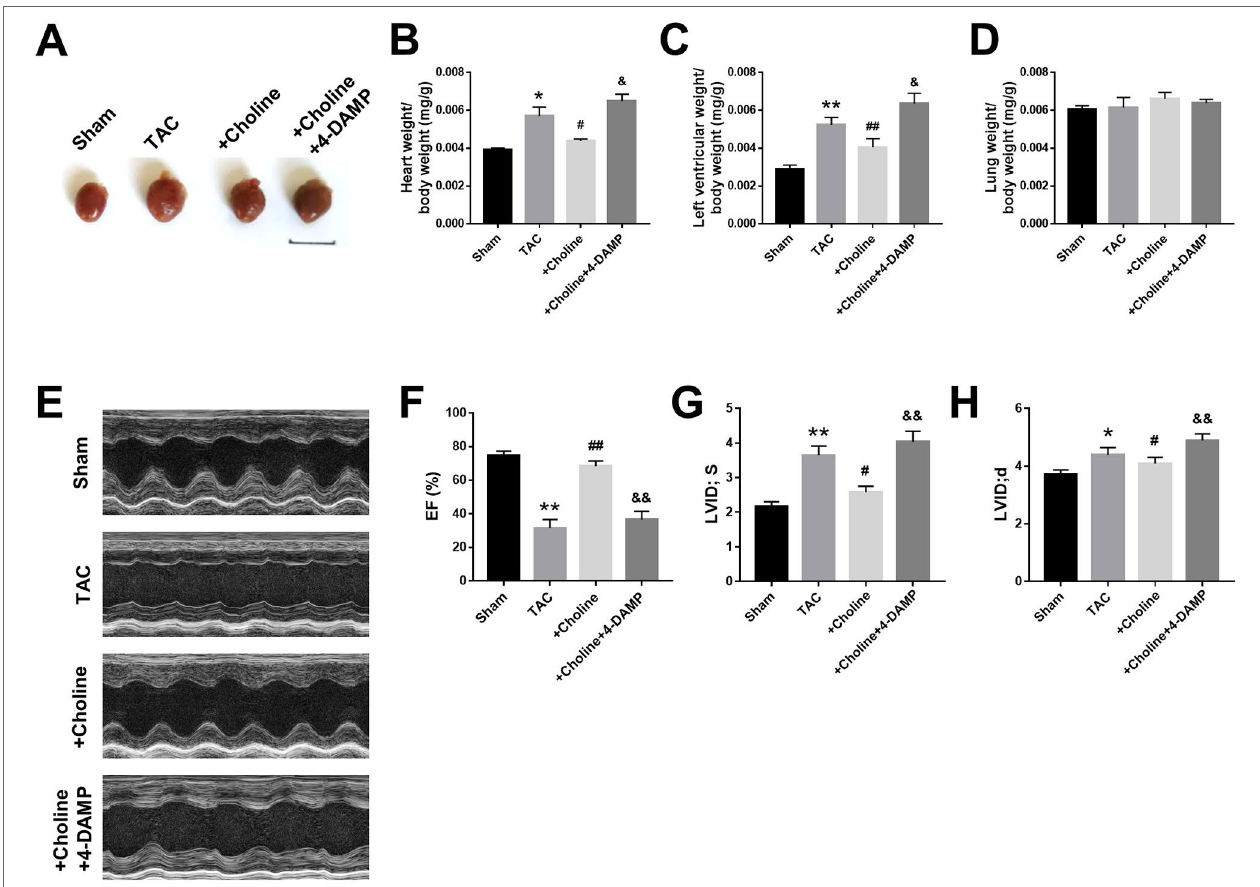
FIgURe 3 | Effects of choline on cardiac function of transverse aortic constriction (TAC) mice model. (A) Representative hearts from sham, TAC, and the mice induced by TAC treated with choline (14 mg/kg per day) and 4-DAMP (0.7 μg/kg/day) for 8 weeks. (B) The ratio of heart weight/body weight (BW). (C) The ratio of left ventricular weight (LVW)/BW. (D) The ratio of lung weight/body weight. (e) Representative echocardiographic images of mouse hearts in each group. (F) Left ventricular ejection fraction (LVEF). (g) Systolic left ventricular internal diameter (LVID, s). (h) Diastolic left ventricular internal diameter (LVID, d). * p < 0.05, ** p < 0.01 vs. sham, # p < 0.05, ## p < 0.01 vs. TAC, & p < 0.05, && p < 0.01 vs. choline, n =